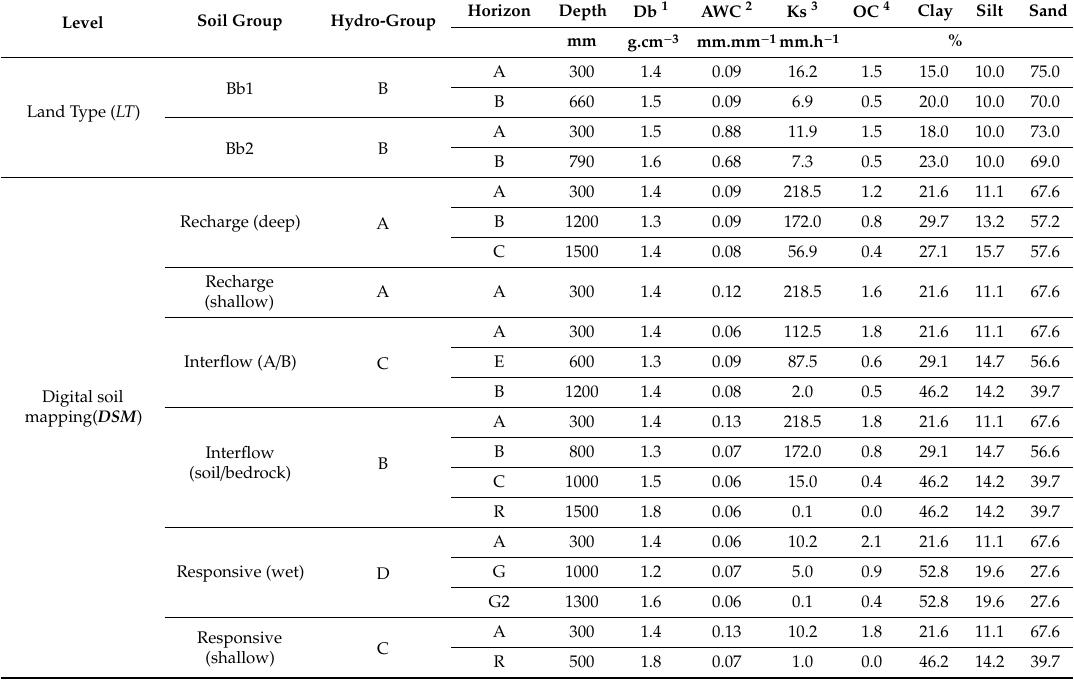
Figure 3. Di ff erent levels of soil information used in the study: ( a ) land type information ( LT ) obtained from the [31] and ( b ) Digital Soil Map ( DSM ) data, produced by [17,35], together with locations of representative profiles used to derive hydraulic properties of the soil types. Table 1. Selected hydraulic properties of the soil horizons in di ff erent soil information datasets.